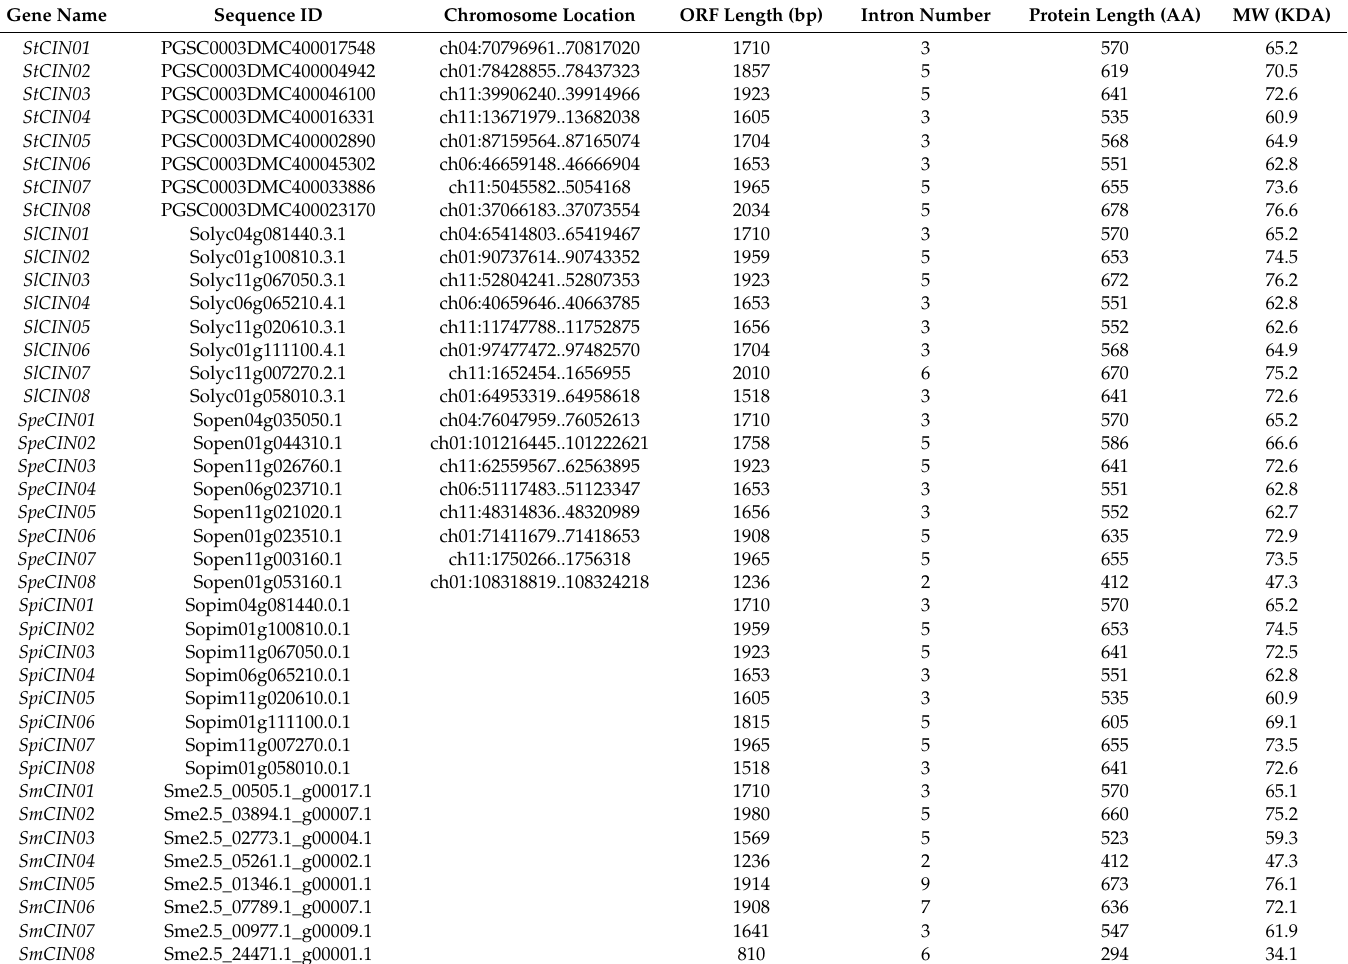
Table 1. List of 40 identified acid- and neutral / alkaline invertase (cytosolic invertase, CIN) members in Solanum